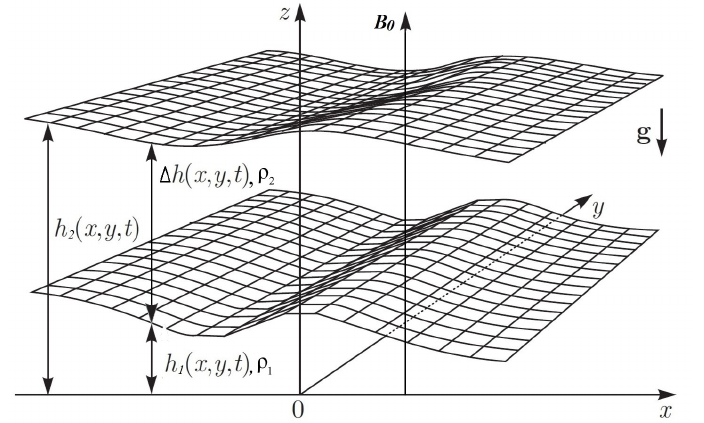
Figure 1. Geometry of two-layer shallow water approximation for stratified flows in an external vertical magnetic